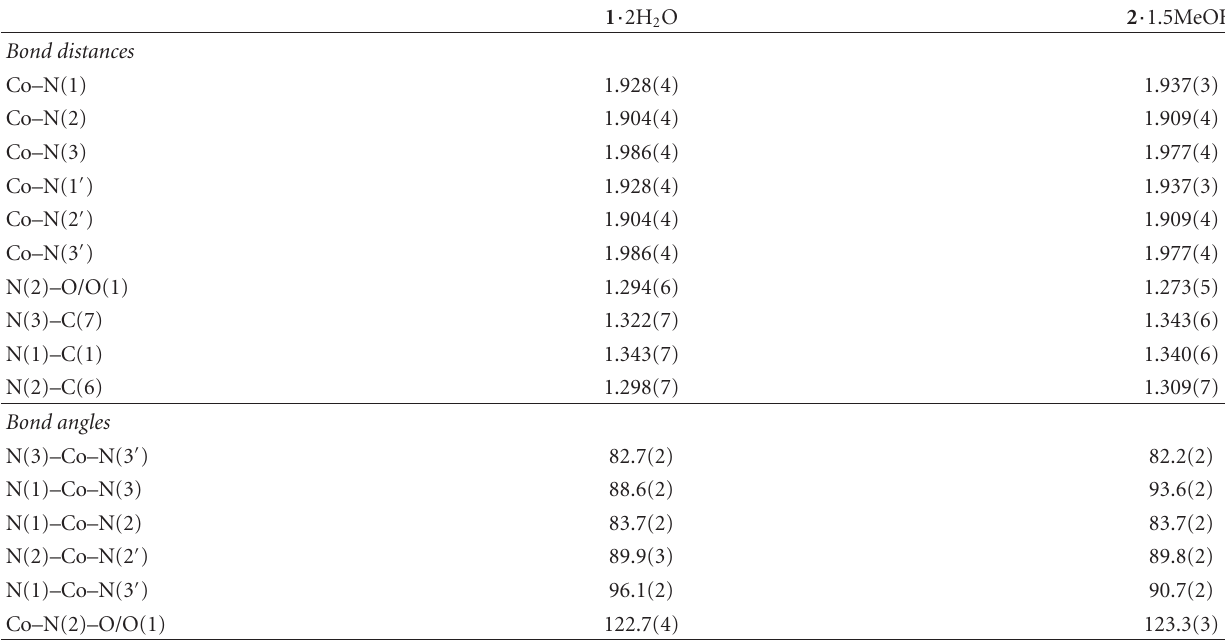
Table 2: Selected bond distances ( ˚A) and angles ( ◦ ) for complexes 1 · 2H 2 O and 2 · 1.5MeOH, a with the estimated standard deviations in parentheses.